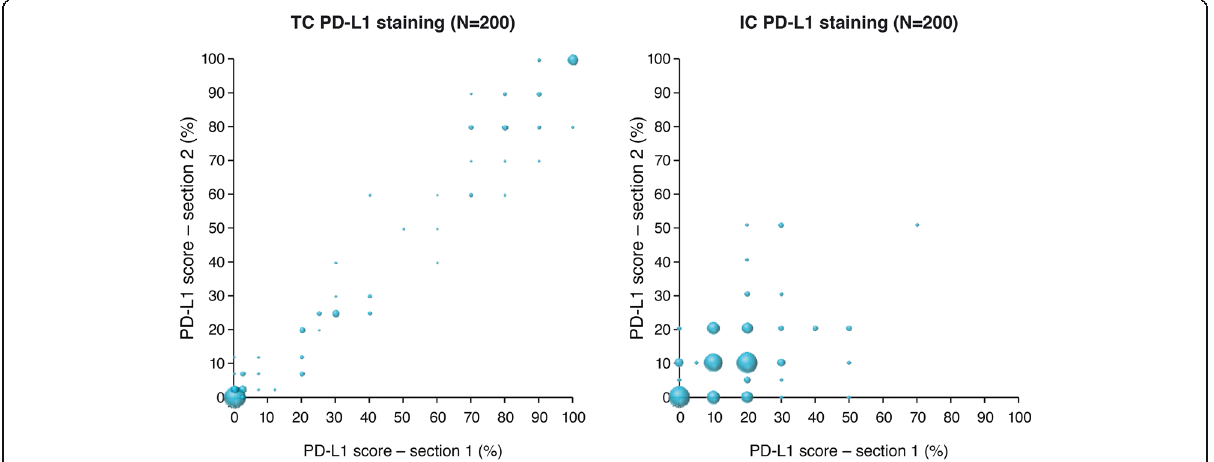
Fig. 3 Correlation in PD-L1 staining between two sections from the same tumor block. Sample size of 200 NSCLC cases. Using the VENTANA PD-L1 (SP263) assay with the VENTANA OptiView DAB IHC detection kit on the automated VENTANA BenchMark ULTRA platform. IC: tumor-infiltrating immune cells; NSCLC: non-small cell lung cancer; PD-L1: programmed cell death ligand-1; TC: tumor cells